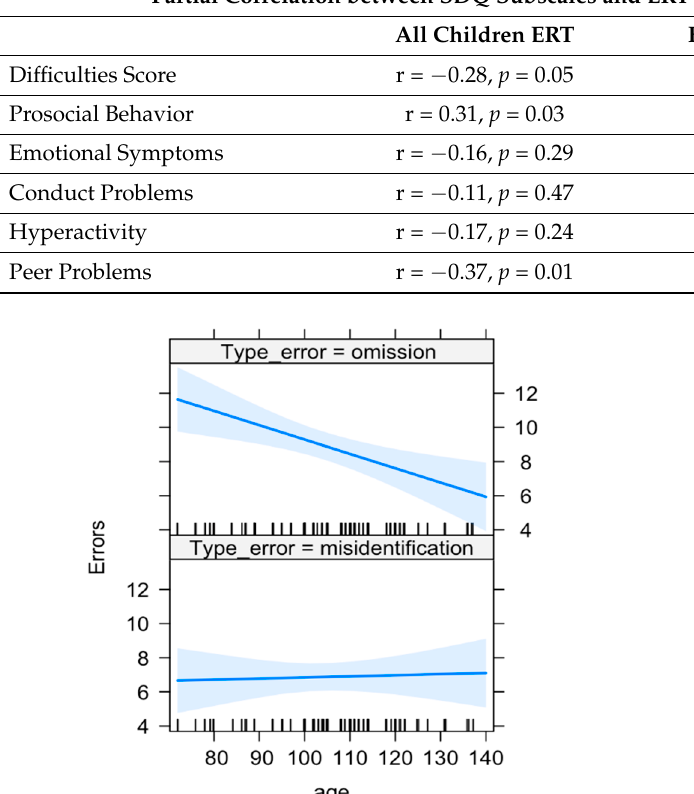
Table 7. Partial correlation between ERT and SDQ, controlling for PSI-Parental Distress.